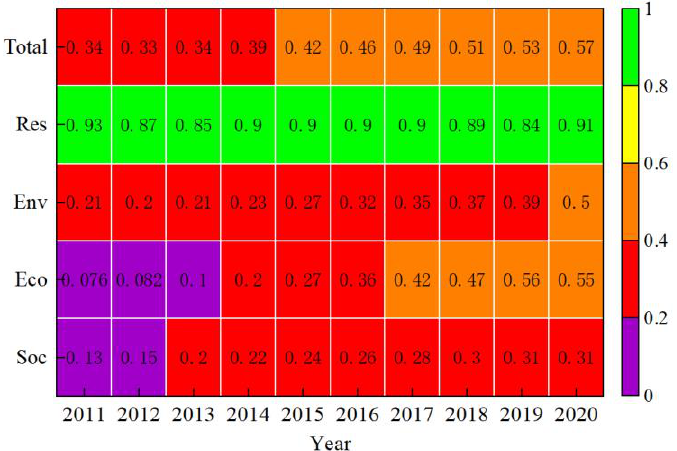
Figure 4. Changes in the degree of high-quality development of regional systems and the whole.